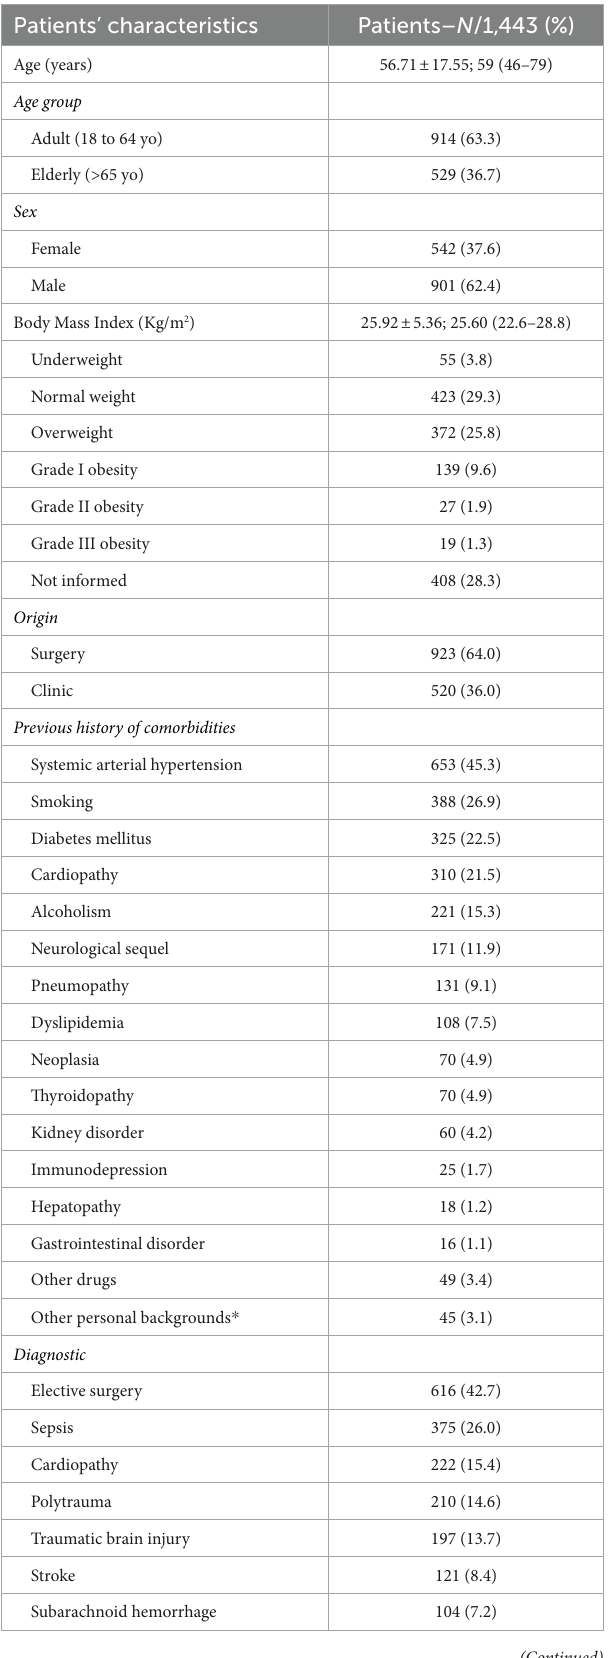
TABLE 1 Characteristics of the patients in the intensive care unit on invasive mechanical ventilation support during the study period (2016– 2019).